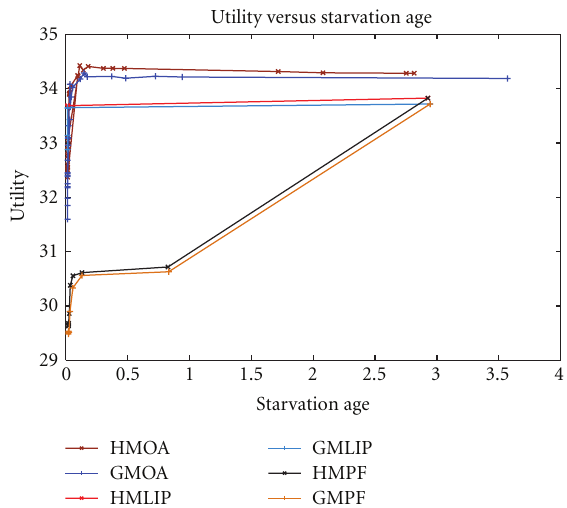
Figure 12: Utility ( (cid:26) Ψ ) versus Starvation Age ( (cid:26) χ ). Greedy MultiChannel Allocation were derived for multiuser multichannel video scheduling. Simulation results demon-